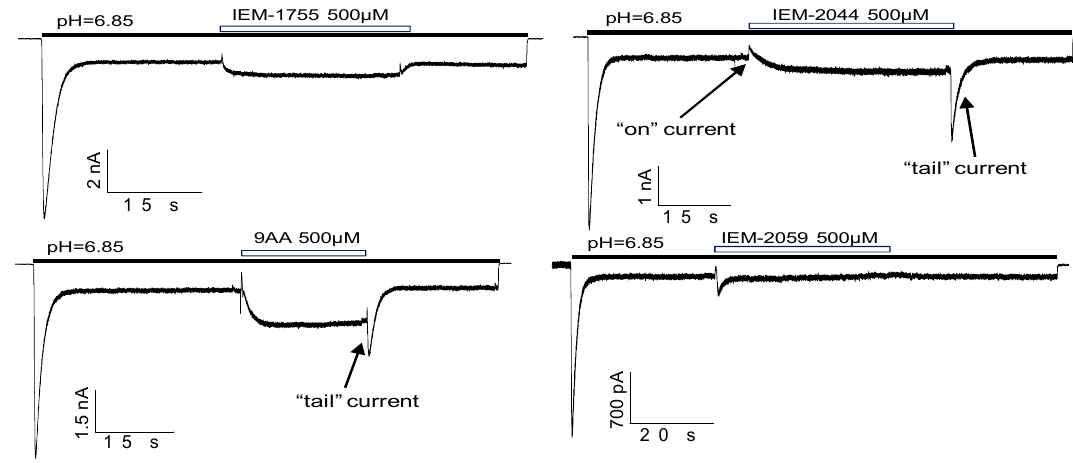
Figure 7. “On” and “tail” currents for different drugs. Transient currents were pronounced for the drugs which caused peak inhibition at pH 6.85 due to the activation shift (9AA, IEM-2044, see Figure 2A).